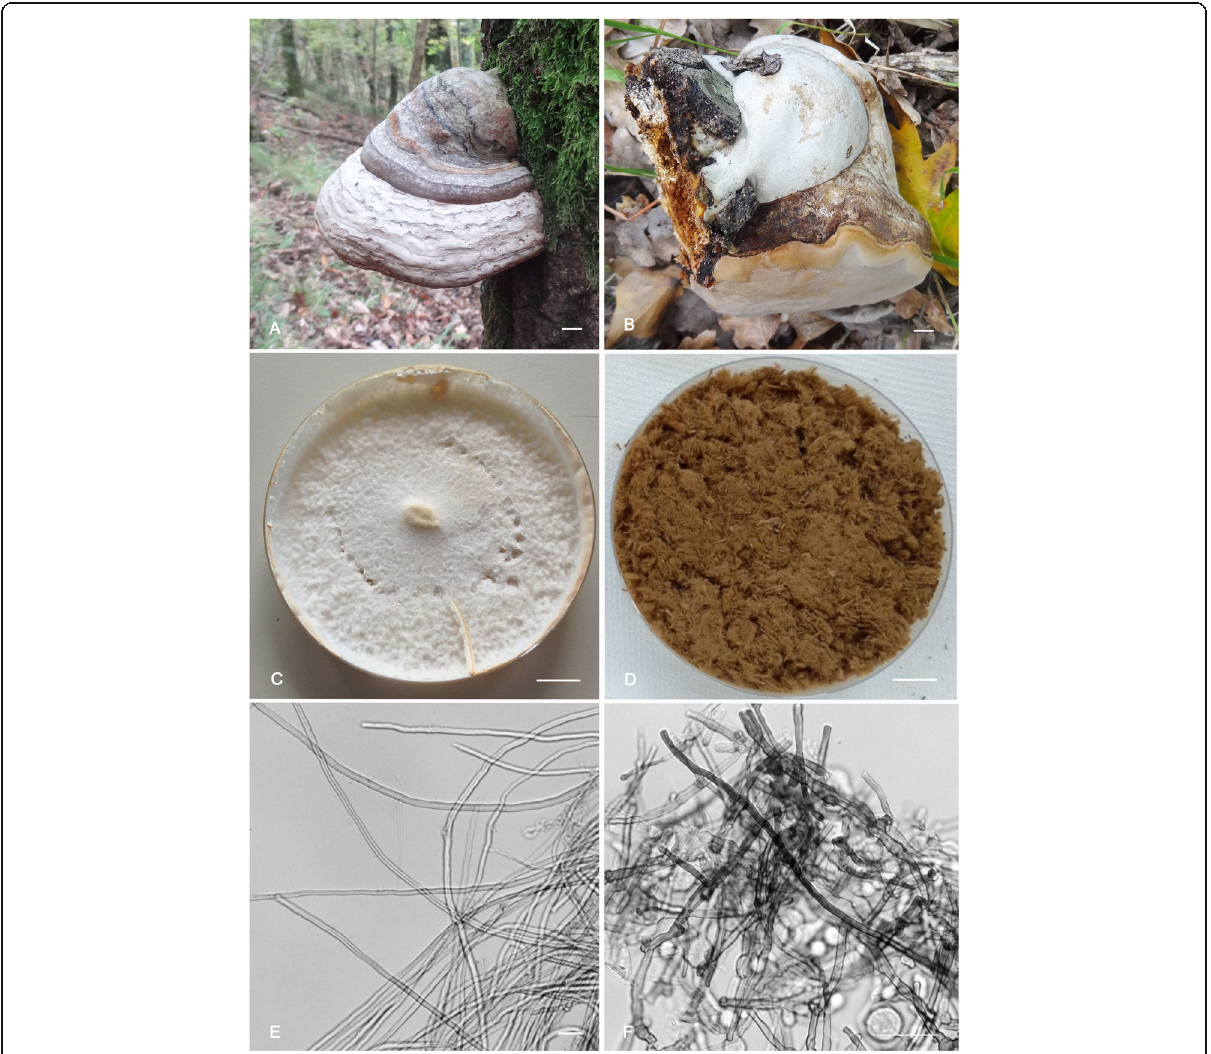
Fig. 3 Fomes inzengae . A. Basidiome of the lectotype (IB20160342) growing on Quercus cerris in the Natural Reserve of Cornocchia. B. Basidiome with new hymenophore formation (positive geotropical reaction) after falling of the host tree (IB20160343). C. Mycelia pure culture after 10 d on 3% MEA at 25 °C (IB20160342). D. Ground basidiome (IB20160342); note the ferruginous brown colour and fluffy consistence. E. Skeletal hyphae as formed after 5 d on 3% MEA at 37 °C (IB20160342). F. Inflated intercalar and terminal hyphal elements after 5 d at 37 °C, stained with Congo red (IB20160342). Bars A-D = 1 cm; E-F = 10 μ